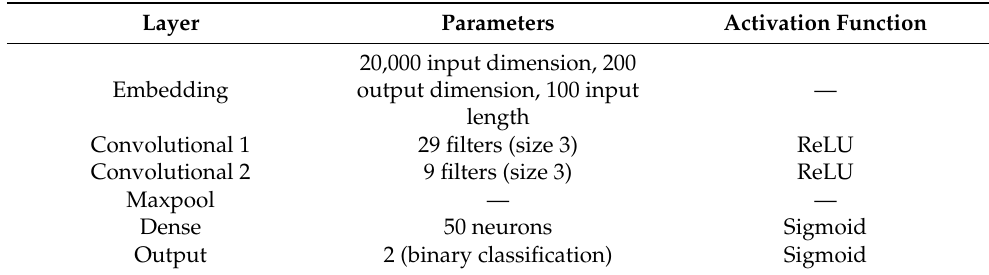
Table 10. Architecture of CNN model trained on text